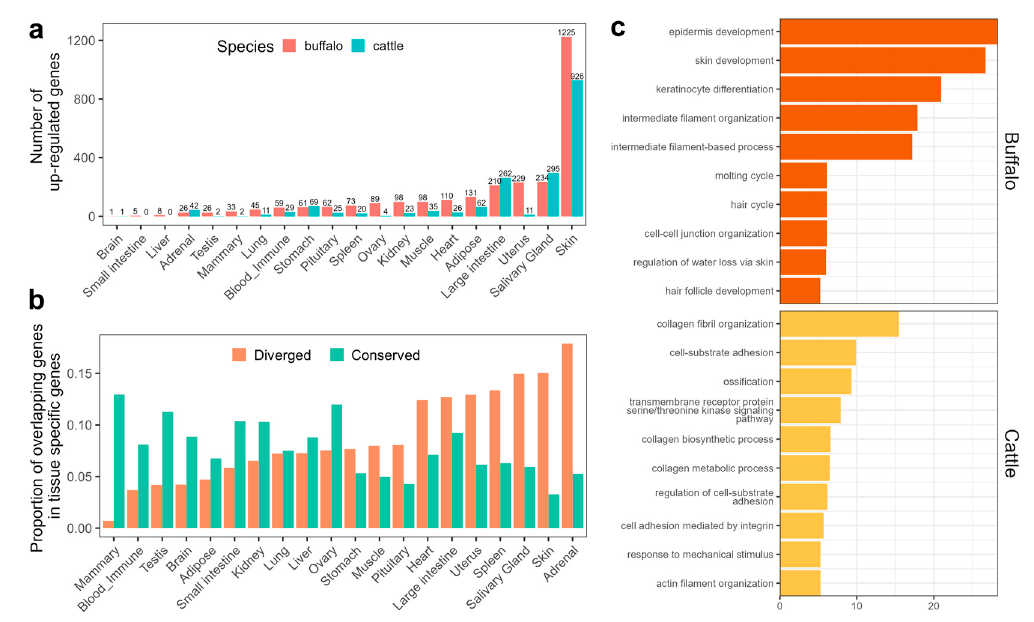
Figure 5. Comparison of average gene expression across 20 tissues between buffalo and cattle. ( a ) A number of significantly upregulated genes across tissues in buffalo (red) and cattle (green) using the cutoff of log 2 (FC) > 1.3 and FDR < 0.05. ( b ) The proportion of overlapping genes between tissue ‐ specific genes and diverged genes (orange) and conserved genes (green) in the tissue ‐ specific gene. ( c ) GO enrichment of significantly upregulated genes in Skin in buffalo and cattle.